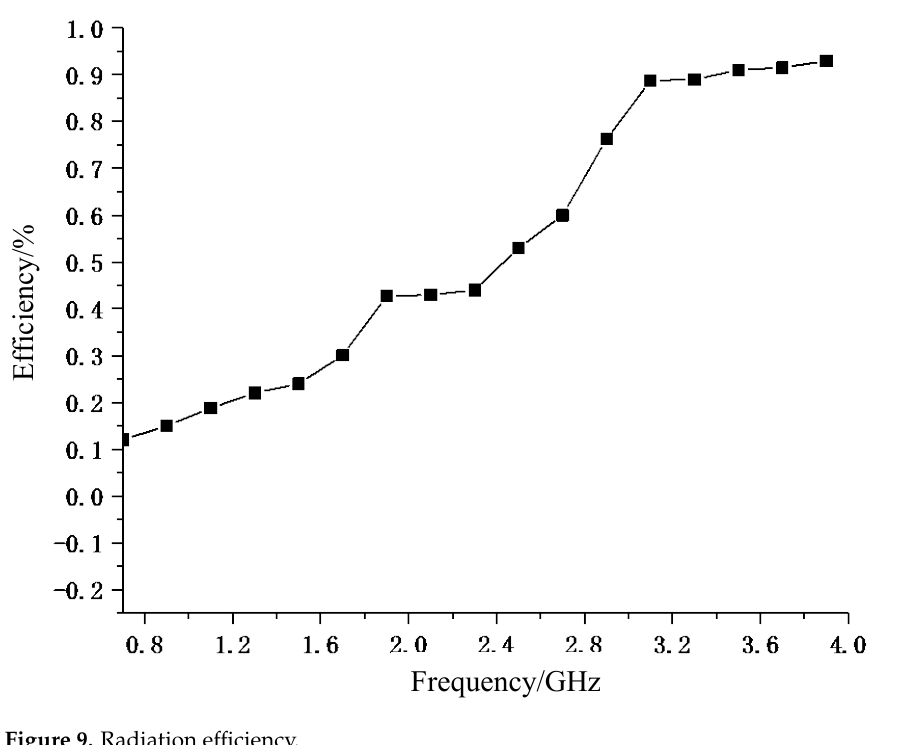
Figure 9. R ad iation efficiency.